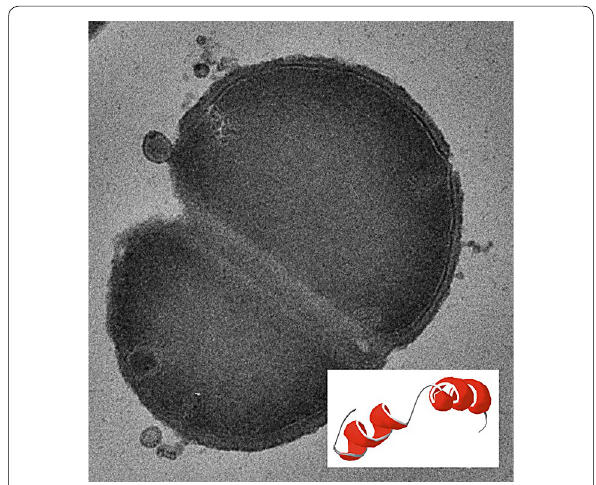
Fig. 1 Structure and action of a peptide antibiotic (NK-2) against Staphylococcus aureus . Visible blebs at the surface are indicative for the peptide-induced destruction of the bacterial membrane (Andrä and Goldmann, unpublished)